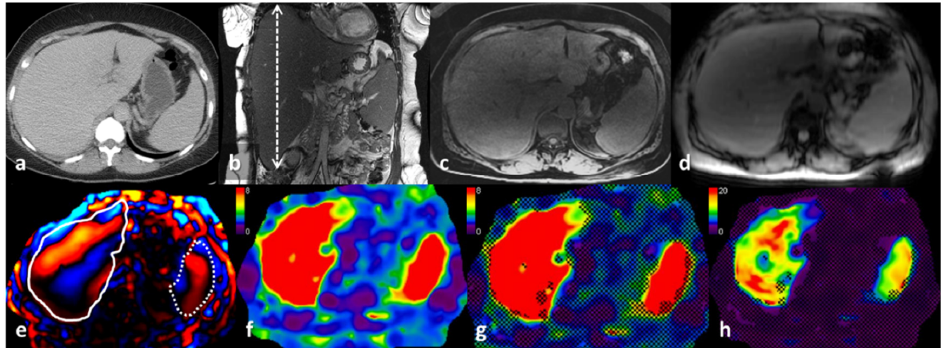
Figure 2. A 49-year-old female with systemic amyloidosis and hepatosplenomegaly on follow up. The axial computed tomography (CT) image ( a ), coronal T2-weighted image ( b ), and axial T1-weighted image ( c ) show hepatomegaly (craniocaudal span in ( b) , 30 cm) and splenomegaly (16 cm). Axial magnitude resonance elastography (MRE) image ( d ), color wave image ( e ), and color stiffness maps ( f – h ) in the upper abdomen. The liver is outlined with a continuous line, and the spleen is outlined with a dotted line on the color wave image ( e ). The color stiffness map ( f ) shows stiffness distribution on the routinely used scale of 0–8 kPa. Note that the entire liver shows an increase in stiffness. The color stiffness map ( g ) is the same, with a 95% confidence overlay. The regions that are not crossed out are regions with reliable measurements. Note that both the liver and spleen are almost completely outlined by the overlay. The color stiffness map ( h ) has a wider scale of 0–20 kPa, and one can see the heterogeneity in the distribution of stiffness. This scale is rarely used in the clinical evaluation of liver fibrosis. The mean ± SD for LSM is 18.1 ± 3.4 kPa, and for SSM, it is 16 ± 2.1 kPa.